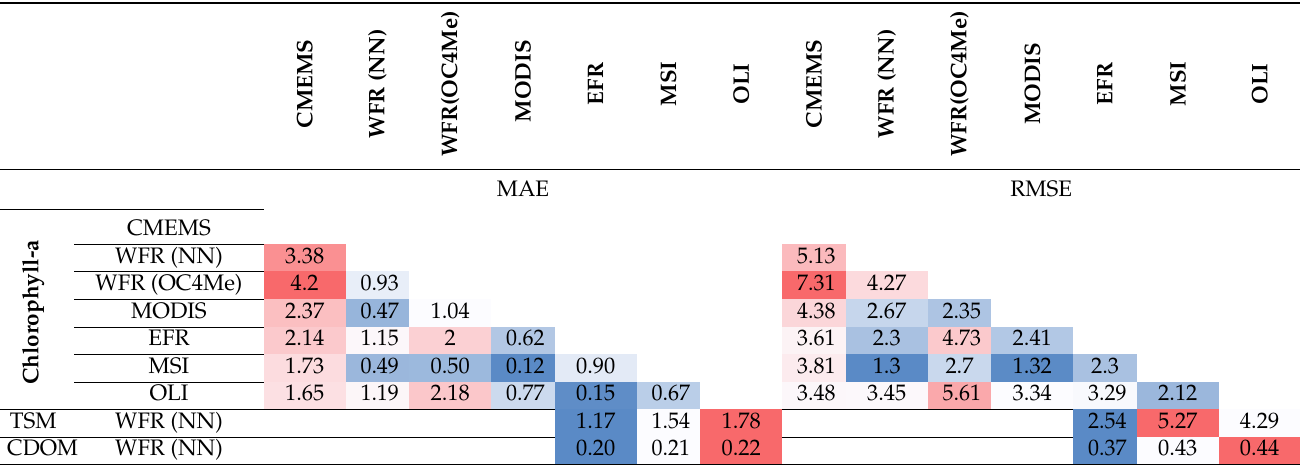
Table 8. Water quality estimation performance analysis metrics (MAE and RMSE) in the coastal